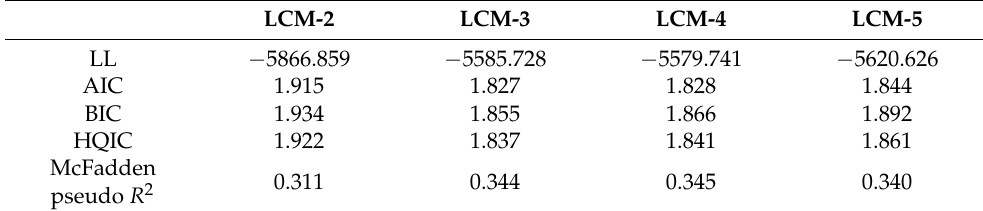
Table 2. Statistical indicators for model comparison.